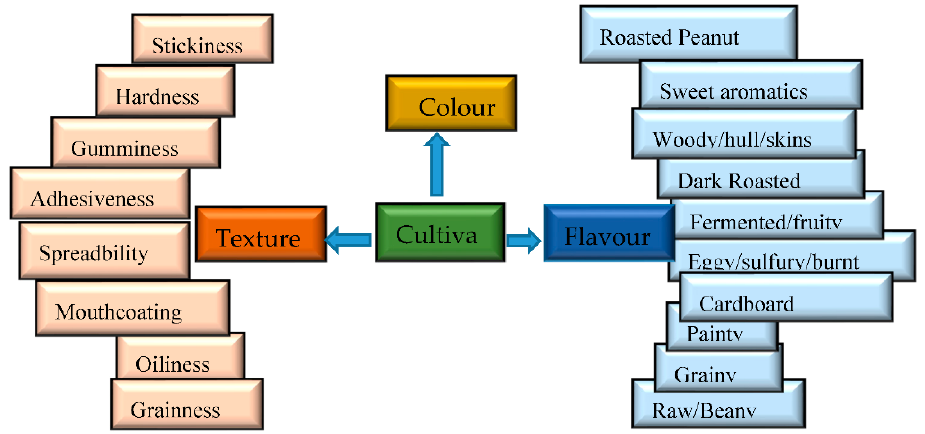
Figure 2. Image showing four of the main quality attributes of peanut butter that are strongly influenced by peanut variety, with some of the applicable